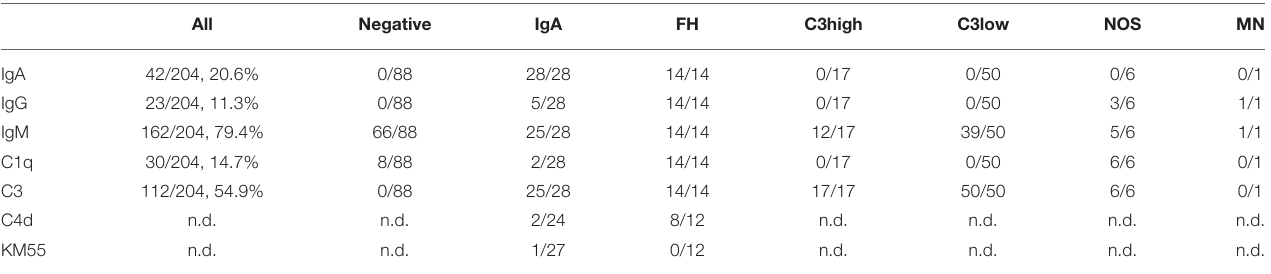
TABLE 1 | Immunohistochemical findings in time zero